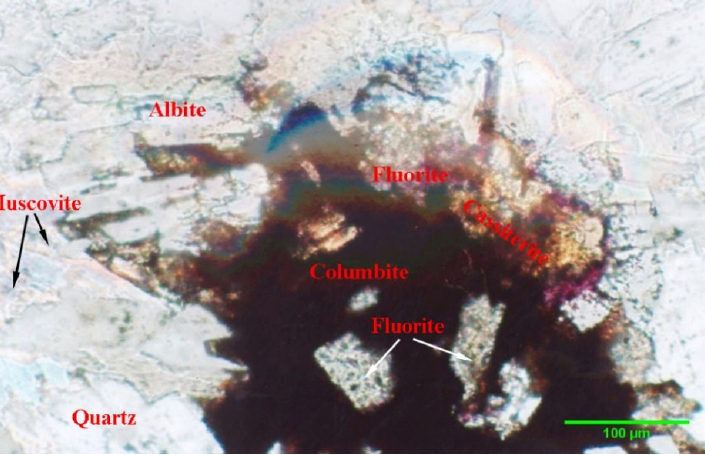
Figure 6. Columbite (dark) associated with cassiterite (brown) and fluorite (purple), distributed in columnar aggregates between albite grains.